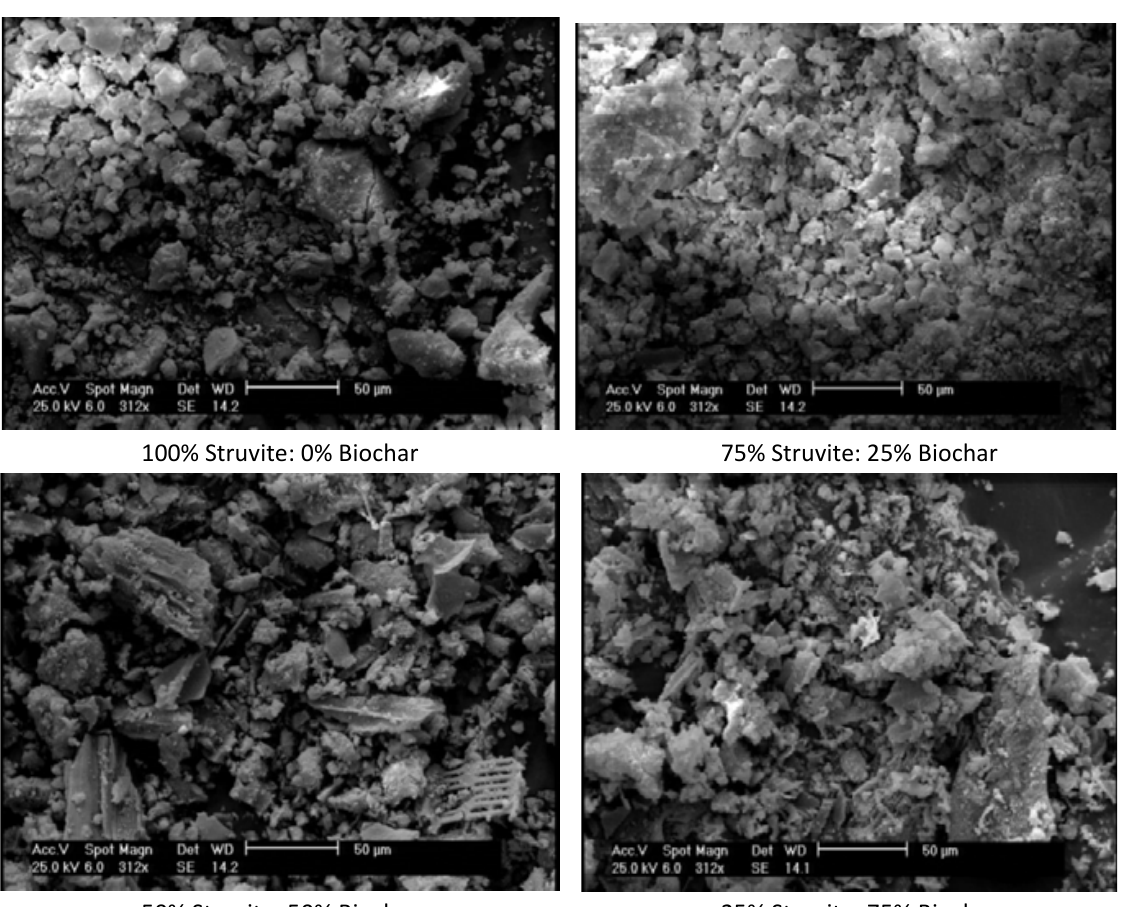
Fig. 2: Scanning Electron Microscopy of samples